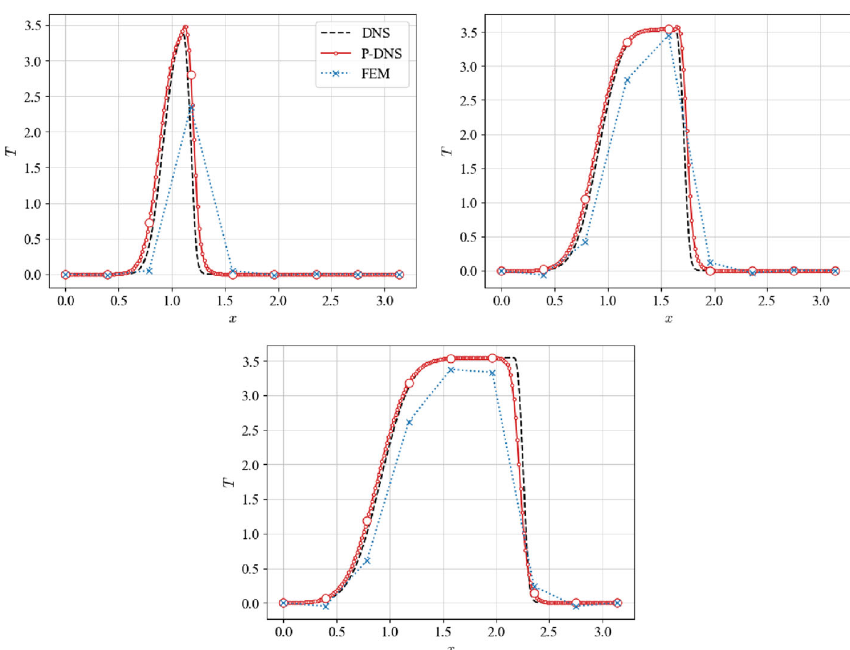
Fig. 8 The Idelsohn’s benchmark. ˆ v = 0 . 2 and nel = 8. Snapshots of the FEM and P-DNS solution for t = 0 . 3 s (top-left), 0.5 s (top-right) and 0.7 s (bottom) while compared with the DNS reference. For the P-DNS solution larger circles are the nodal values and smaller circles are the values on the np dicretization points of the